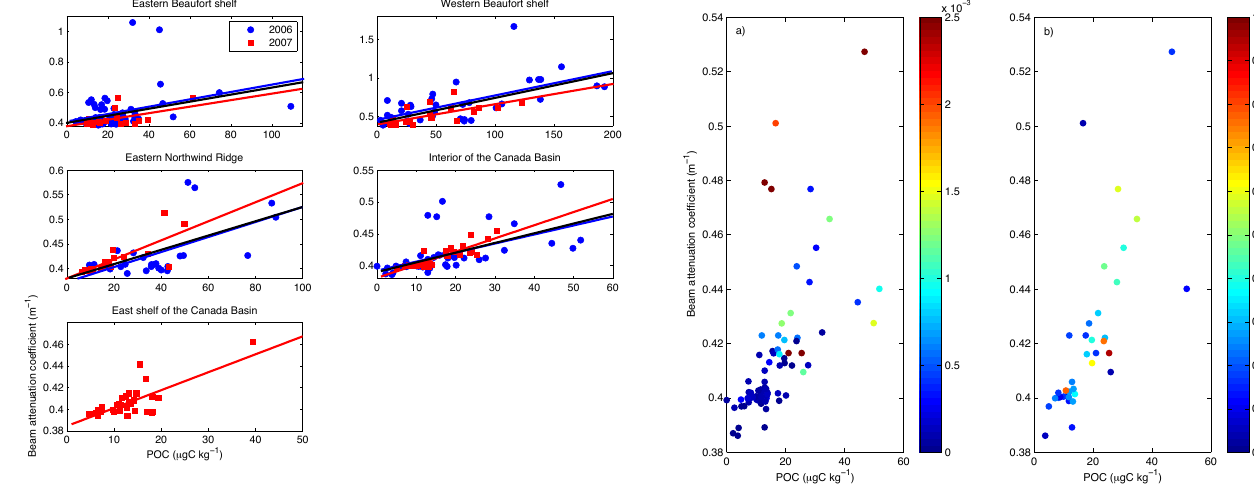
Fig. 17. Relationship for the stations within the interior of the Canada Basin between (a) attenuation and POC with the Brunt- V¨ais¨al¨a-frequency (s − 1 ) in colour and (b) attenuation and POC with the ratio of POC to TSS in colour. There are fewer points in plot b) because TSS was sparsely sampled in